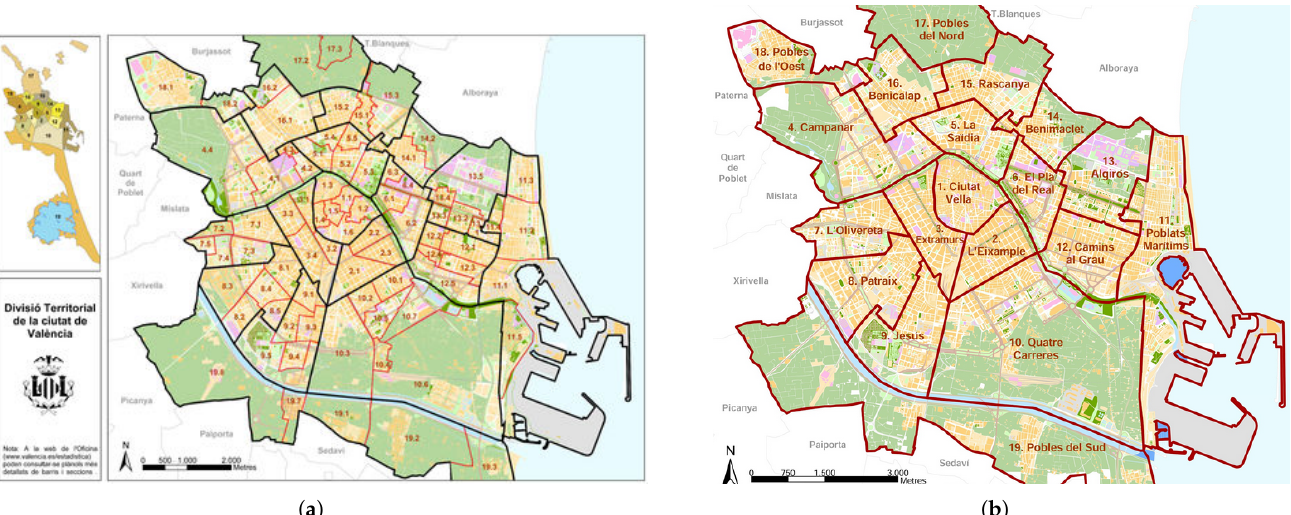
Figure 1. Territorial division of the city of Valencia. Source: Valencia City Council. ( a ) Neighbourhoods. ( b )